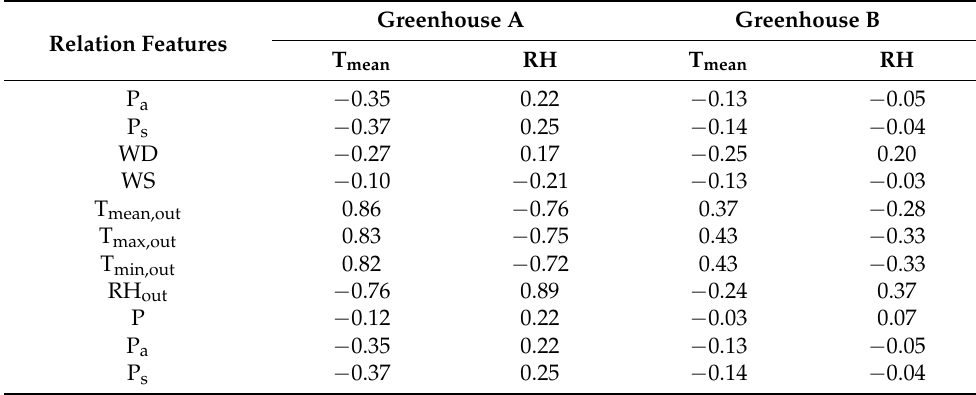
Table 1. Correlation between indoor and outdoor meteorological parameters.